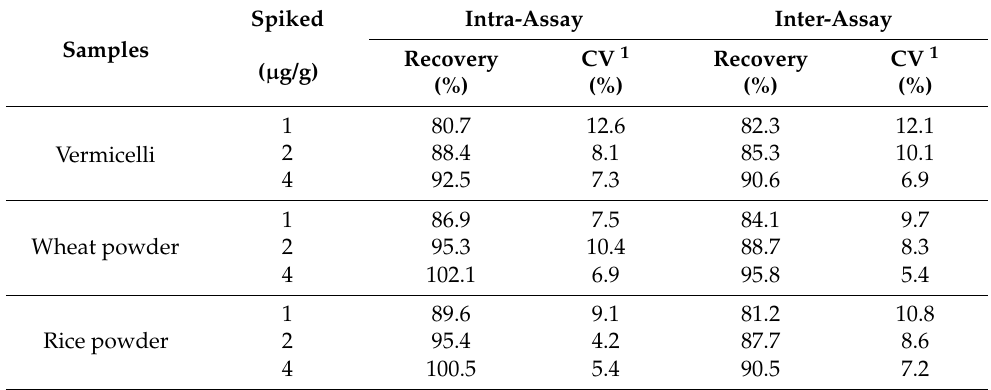
Table 1. Recovery, coefficient of variation of vermicelli, wheat and rice powder samples using fluorescence sensor ( n = 3).